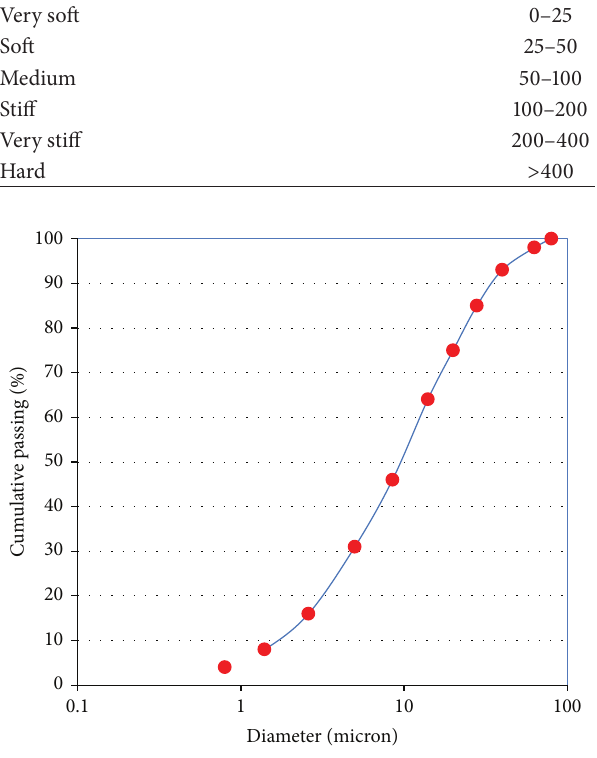
Figure 2: Particle size distribution of the dredged